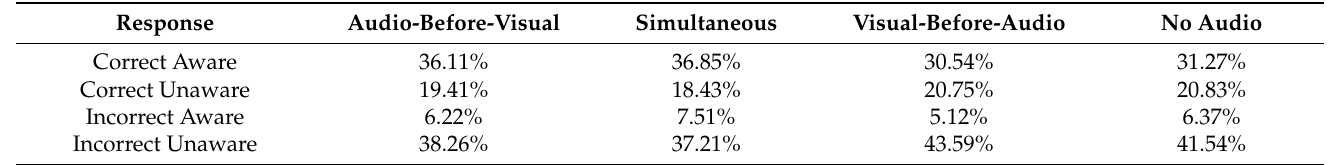
Table 2. Percentage of the types of responses (i.e., correct/incorrect and aware/unaware) per condi- tion for Experiment